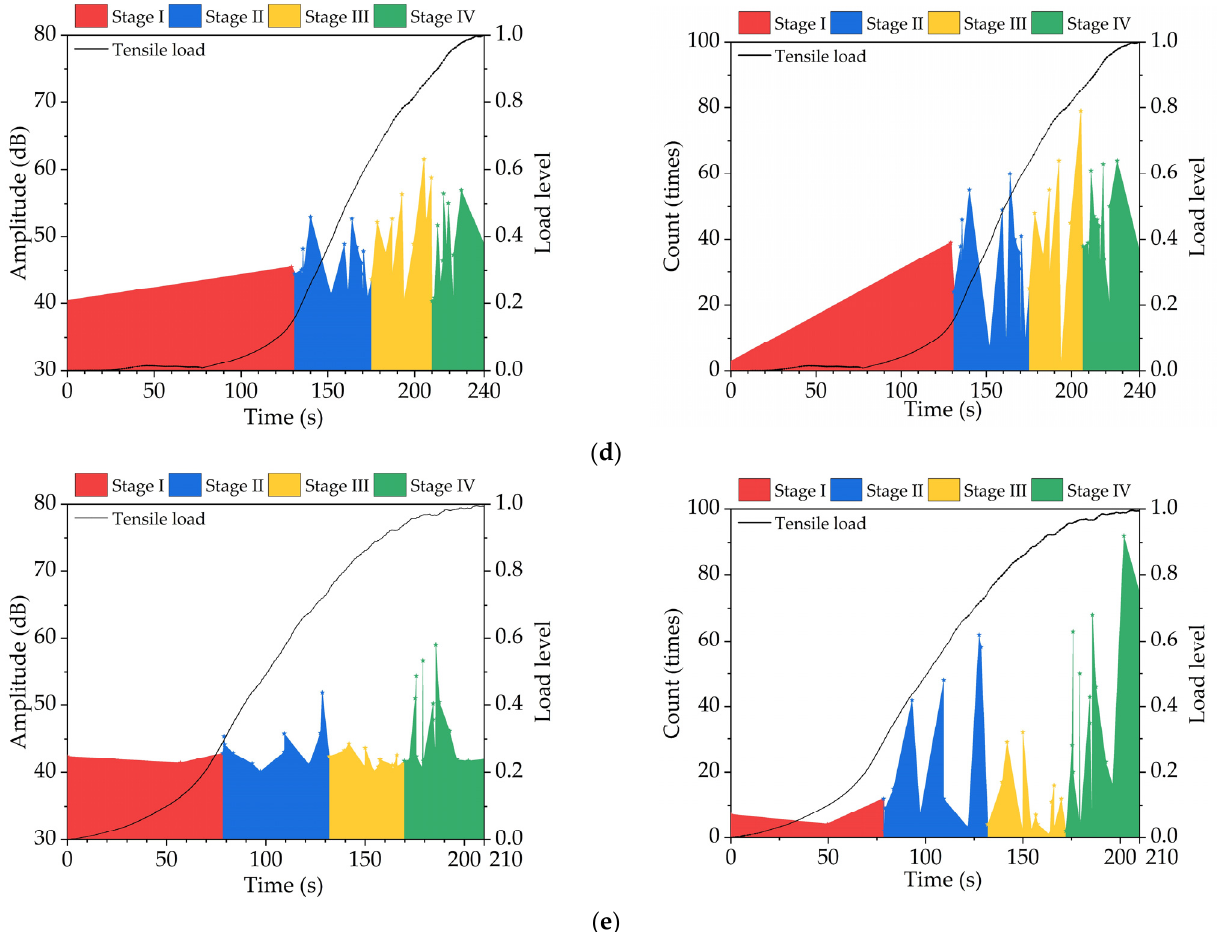
Figure 6. The AE direct parameters (amplitude and count) versus tensile load level for asphalt mixture subjected to F-T conditions: ( a ) AE amplitude/count vs. load level under 0 cycle; ( b ) AE amplitude/count vs. load level under 3 cycles; ( c ) AE amplitude/count vs. load level under 9 cycles; ( d ) AE amplitude/count vs. load level under 15 cycles; ( e ) AE amplitude/count vs. load level under 21 cycles.